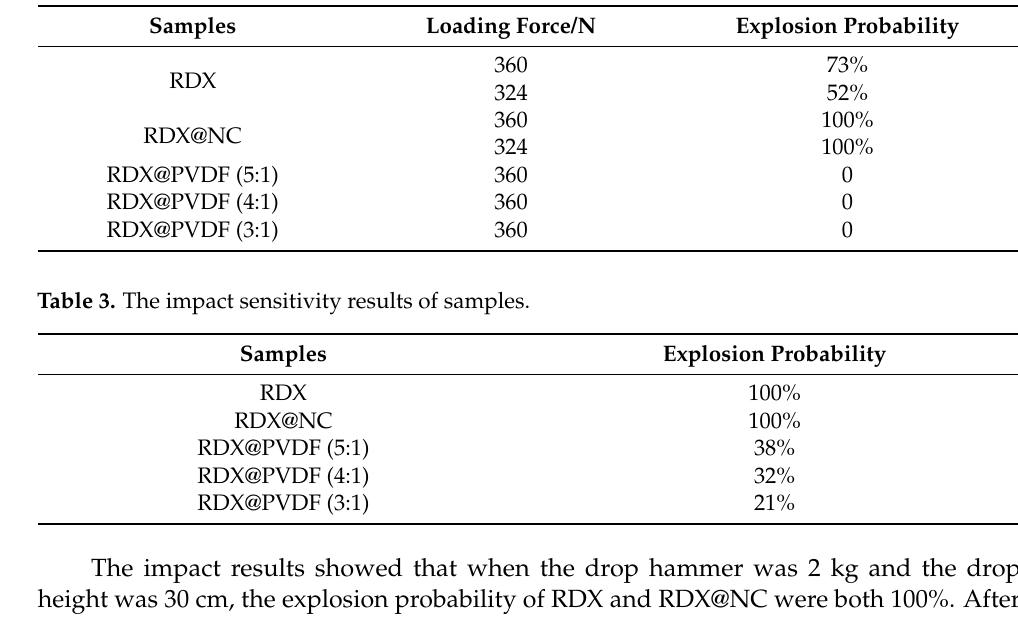
Table 2. The friction sensitivity results of samples.